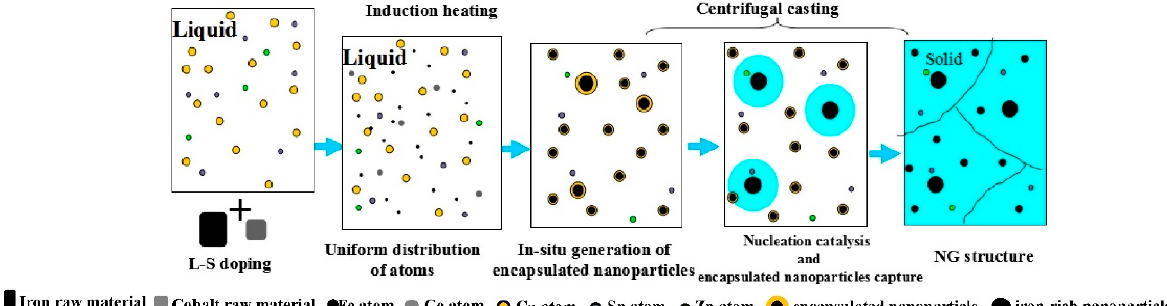
Figure 2. Schematic diagram of NPFG structure in situ formed in cast Cu-10Sn-2Zn-1.5Fe-0.5Co (wt.%) alloy, reprinted with permission from ref. [76], 2022, Elsevier.